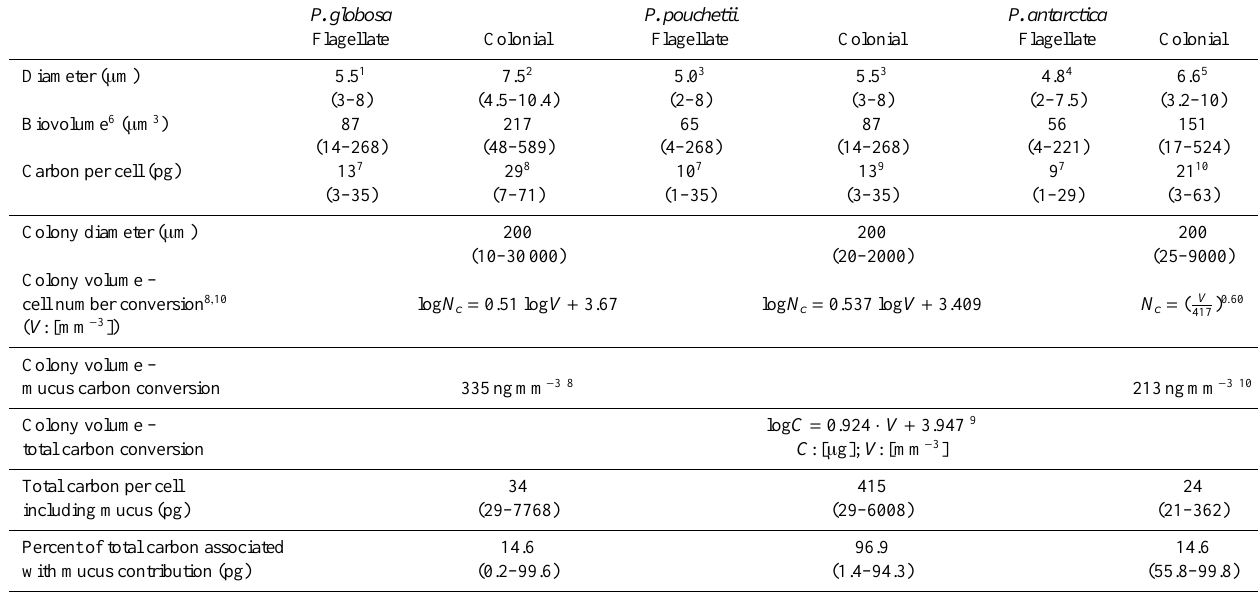
Table 2. Literature values for conversion factors from abundance to biomass. Cell diameters, biovolumes, carbon content and colony number conversions for P. globosa , P. pouchetii , and P. antarctica . Reported means with ranges given in parentheses. P.